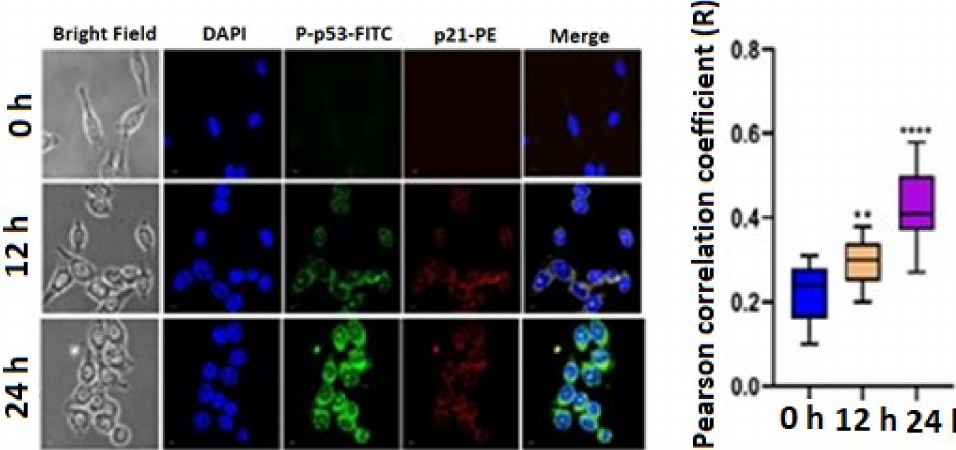
Figure 6. Immunofluorescence images showing the qualitative expression of P-p53 and p21 after treatment with 3 µ g/mL TrzTFPPOP for 12 h and 24 h. Nucleus was counterstained with DAPI (magnification: × 60). Statistical mean fluorescence intensity plot is also added on right with respect to control, which is symbolized by ** and